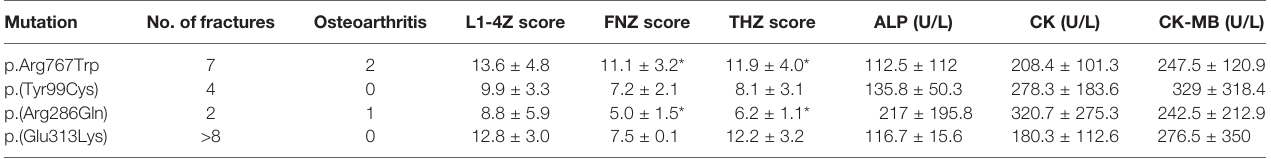
TABLE 8 | Clinical characteristics and auxiliary examinations in association with four common mutations. Mutation